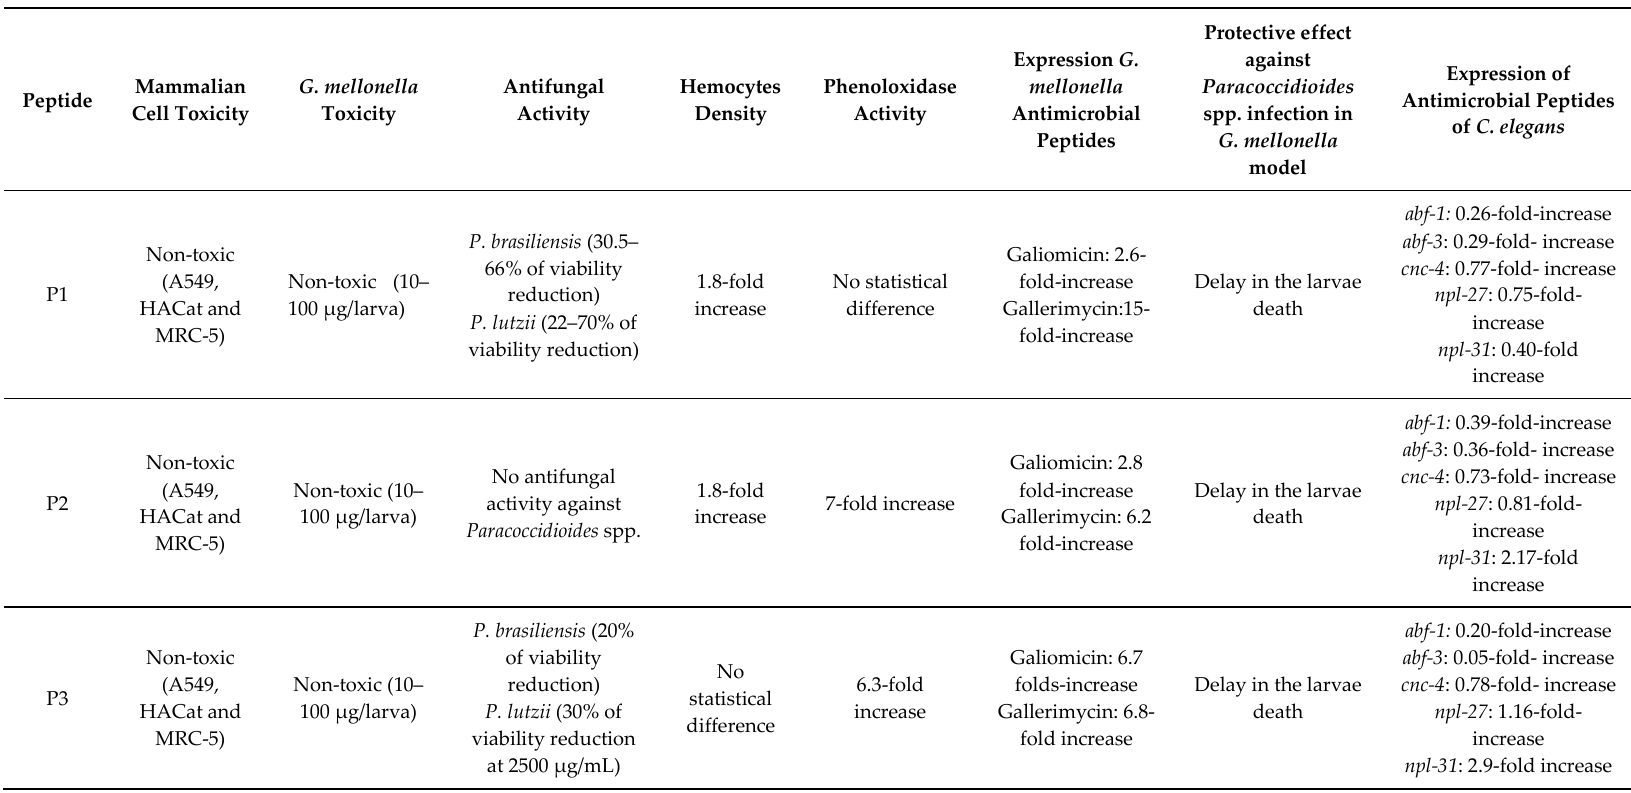
Table 3. Summary of the 14-3-3 peptides effect in vitro and invertebrate